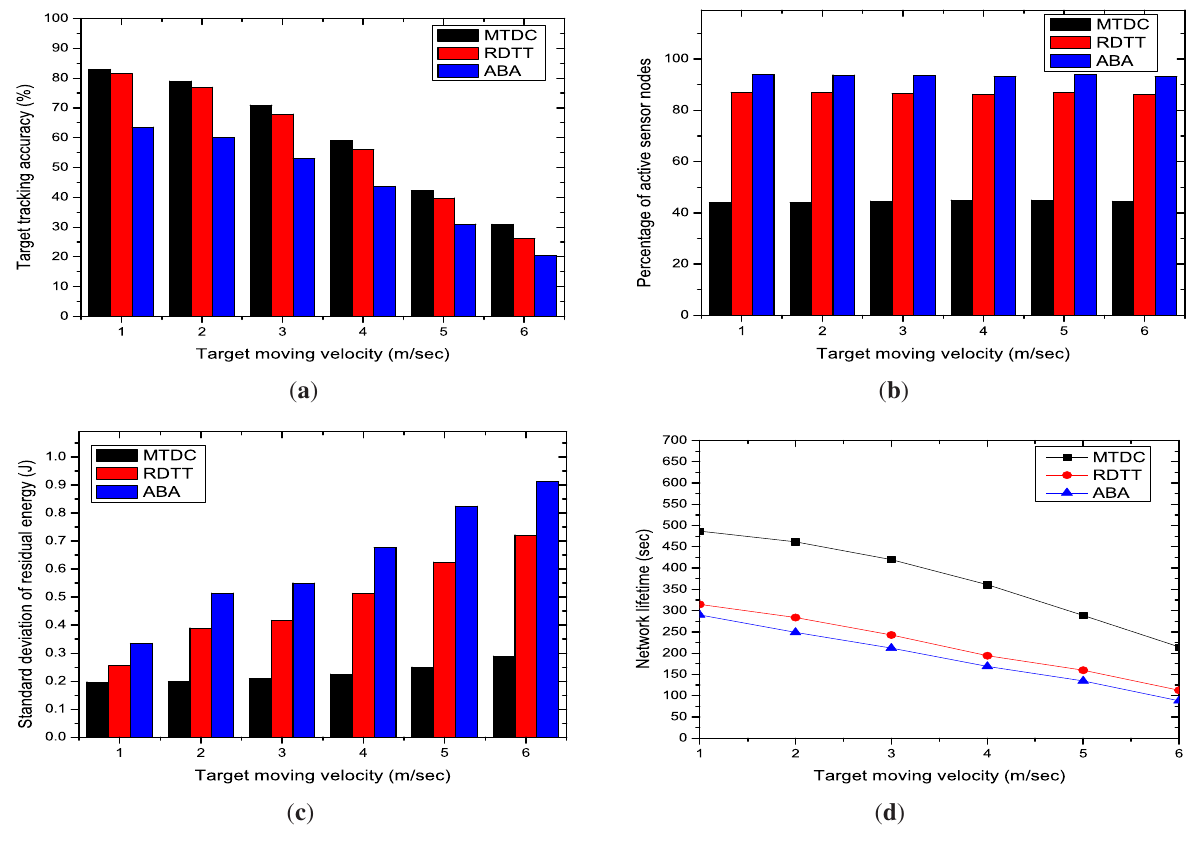
Figure 10. Impacts of target tracking velocity. ( a ) Target tracking accuracy; ( b ) percentage of active sensing nodes; ( c ) standard deviation of the residual energy; ( d ) network